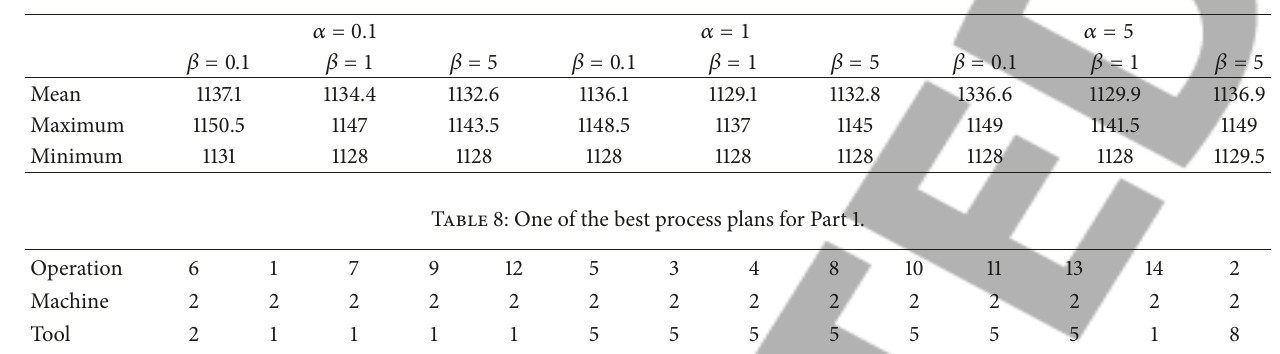
Table 7: Determination of varying combinations of 𝛼 and 𝛽 .